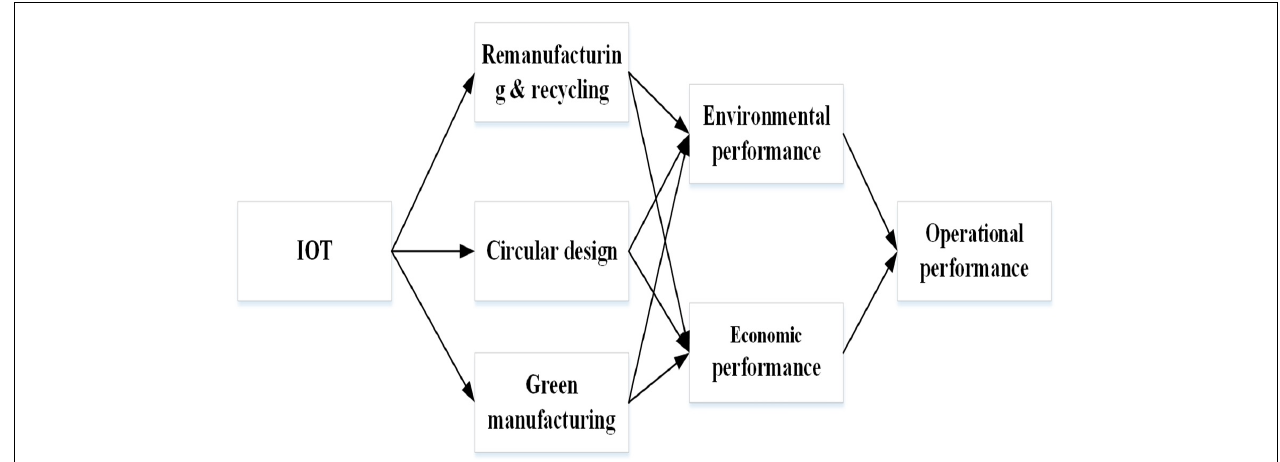
FIGURE 1 | Conceptual